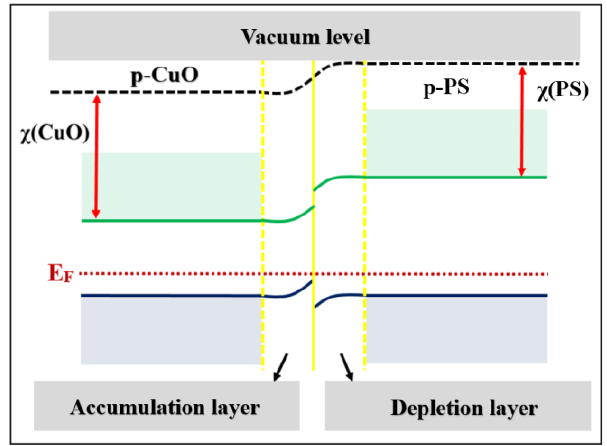
Figure 6. Energy band diagram of the CuO/PS [26].